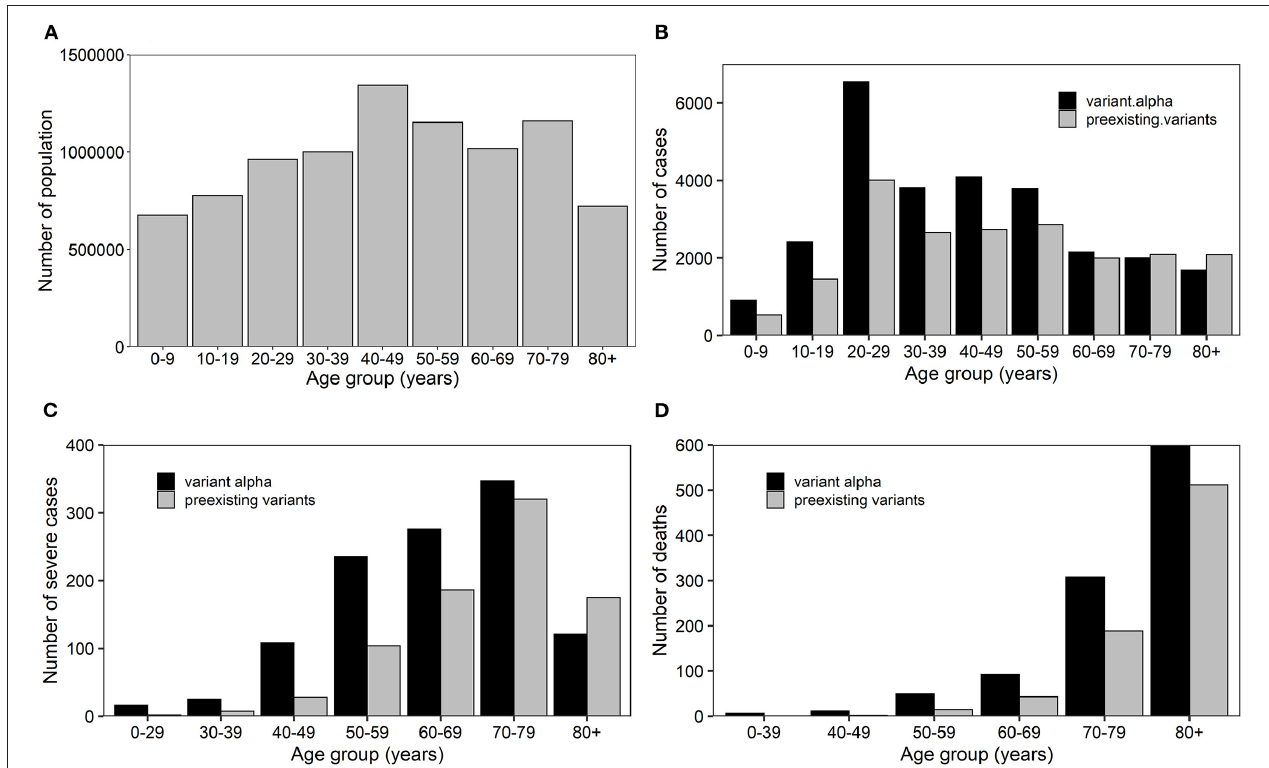
FIGURE 2 | Age distribution of epidemiological characteristics of COVID-19 in Osaka. (A) Population dynamics in Osaka in 2019. (B) Absolute number of cases, (C) severe cases and (D) deaths due to preexisting and variant alpha strains of COVID-19 in